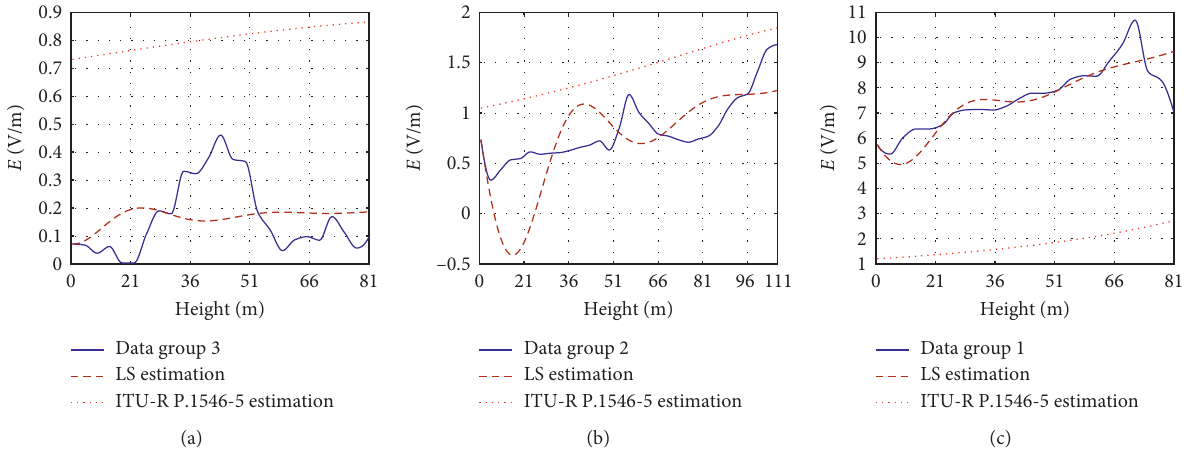
Figure 8: LS estimate for (a) “data3,” (b) “data2,” and (c) “data1.” Table 4: Relative and RMS errors values for LS fitting of inter- polated datasets.